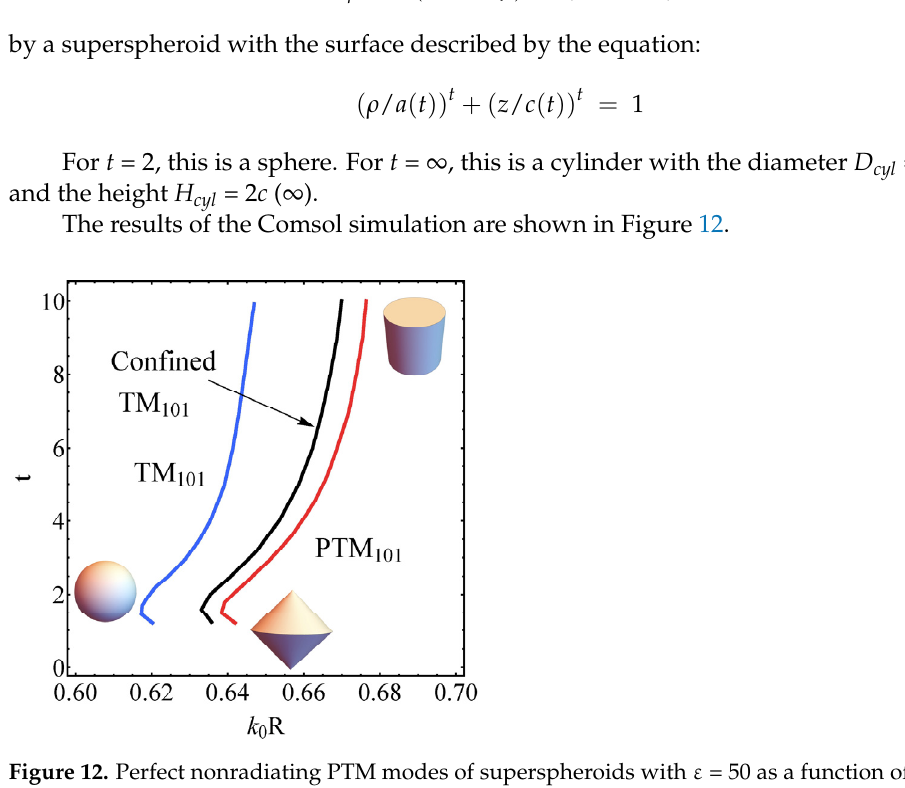
Figure 13. The dependence of logarithms of scattered power (blue), stored energy (red), and radia- tion quality factor Q = ω W stored /P scat (black) on the size parameter of a superspheroid with D/H = 0.96, t = 8 obtained as a result of the Comsol simulation . TM symmetric excitation (23), ε = 50, α = π /4. The insets show the field distribution of the perfect nonradiating modes and the cross-section of the